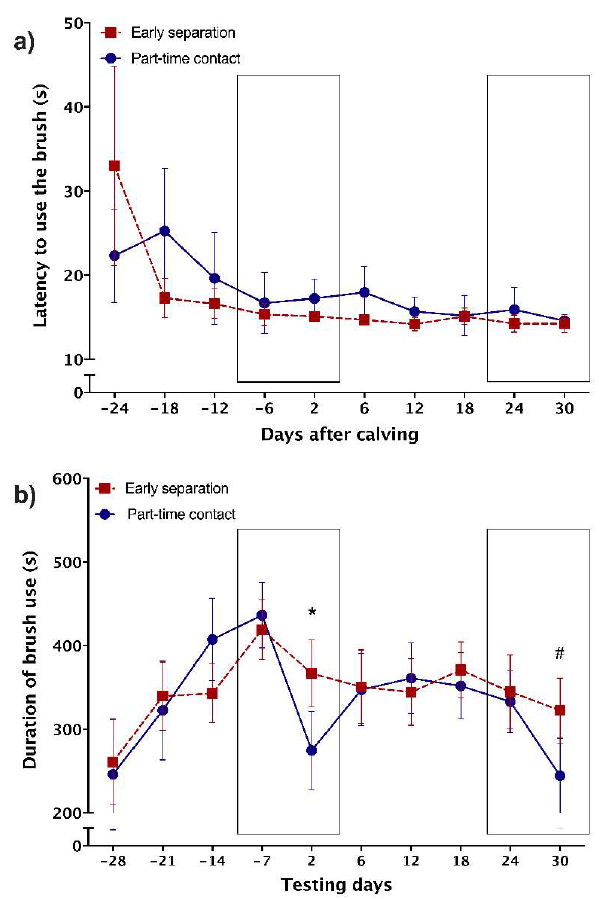
Figure 2. Separation from the calf induced changes in brush use in dairy cows. ( a ) Latency (mean ± SE) to use the brush and ( b ) brush use (mean ± SE) for early permanently separated cows (i.e., per- manently separated from their offspring within 2 h of birth; n = 12) and part-time contact cows (i.e., allowed 24 h of continuous contact after birth and then 12 h/d of contact for 29 days before perma- nent separation; n = 11). Cows were progressively habituated to the testing routine explaining the progressive decrease in latency and increase in brush use over the prepartum period. Please note that one cow was an extreme outlier for latency to use the brush on days −24, −18, and −12 and was thus not represented in this figure. The last measure preceding calving was used for comparisons regarding the first separation (day 2 postpartum). Similarly, we used data from day 24 as a baseline when testing the effect of separation on day 29 (and tested on day 30). Boxes represent the periods for which statistical comparisons were made to assess the effects of separation. Data presented came from Experiment 2. The asterisk represents a significant day × treatment interaction and the # rep- resents a significant effect of time in the part-time contact treatment. 4. Discussion The aim of this study was to assess whether cows would reduce their use of a me- chanical brush after experiencing parturition and separation from their calf compared to brush use in the week before calving. Cows showed a reduced use of a mechanical brush in the days after parturition and did not return to the prepartum level of brush use after calving. In addition, cows showed a drop in brush use after separation from their calf on day 2 and day 30 postpartum. This reduction in low-resilience behaviors indicate that the postpartum period and separation from the calf challenge the welfare of dairy cows.